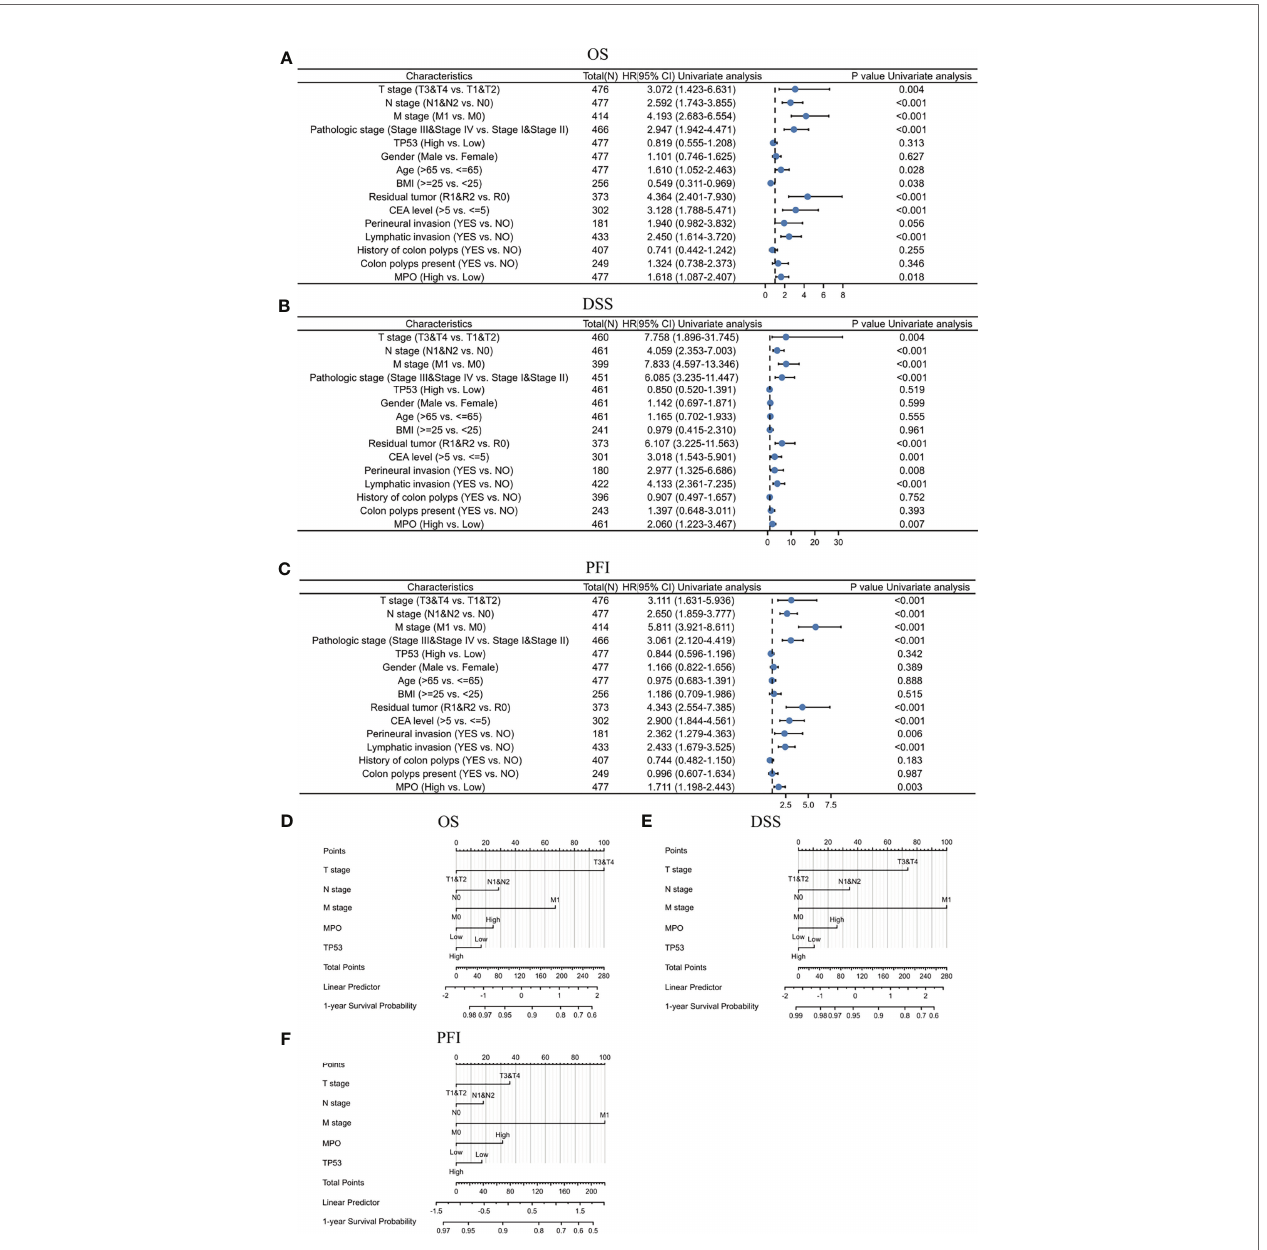
FIGURE 3 | Univariate analysis of MPO for survival using the Cox regression model and nomogram based on MPO and clinical variables for survival in CRC. (A) Univariate analysis of prognostic factors for OS using the Cox regression model. (B) Univariate analysis of prognostic factors for DSS using the Cox regression model. (C) Univariate analysis of prognostic factors for PFI using the Cox regression model. (D) Nomogram for OS prognosis in CRC. (E) Nomogram for DSS prognosis in CRC. (F) Nomogram for PFI prognosis in